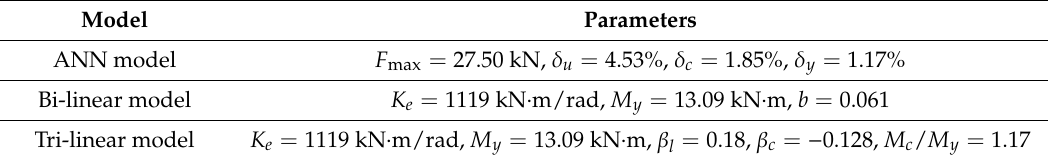
Table 5. ANN-based method for the LP model of the RC column sample